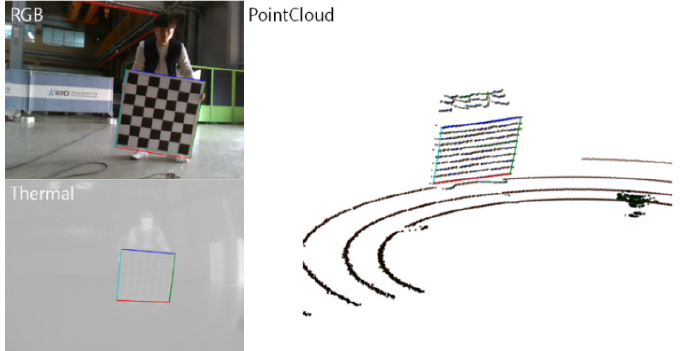
Figure 14. RGB and thermal input images and 3D LiDAR data.